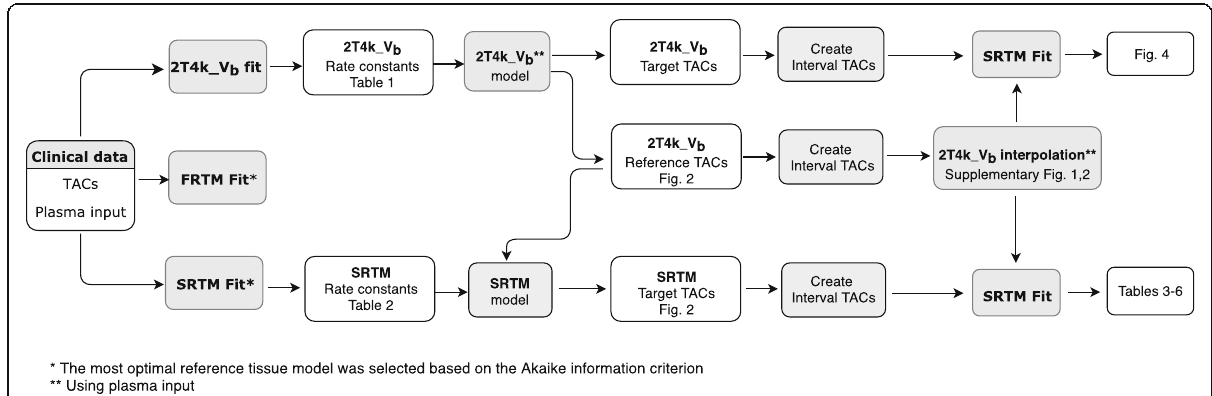
Fig. 1 Overview of the kinetic models used during each step of the analysis